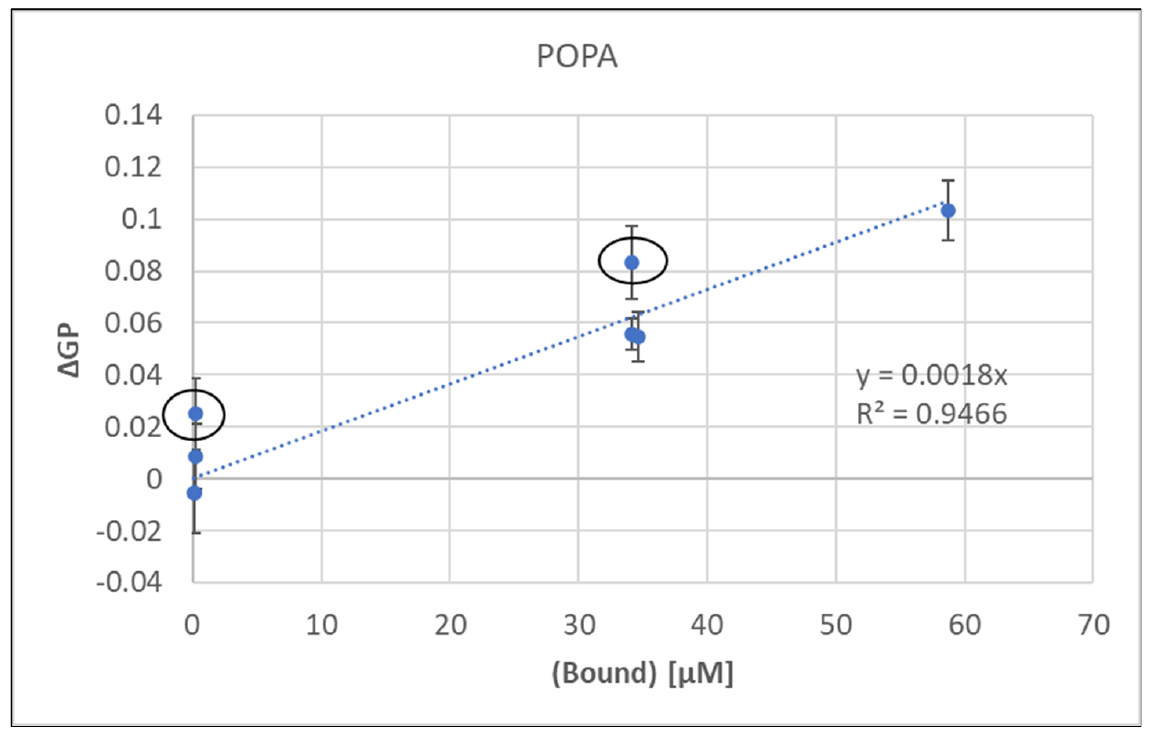
Figure 1. Change in measured GP versus calculated bound metal concentrations of Mn, Ca and Mg and mixtures thereof. Circles represent binary data points that will be discussed in the text.